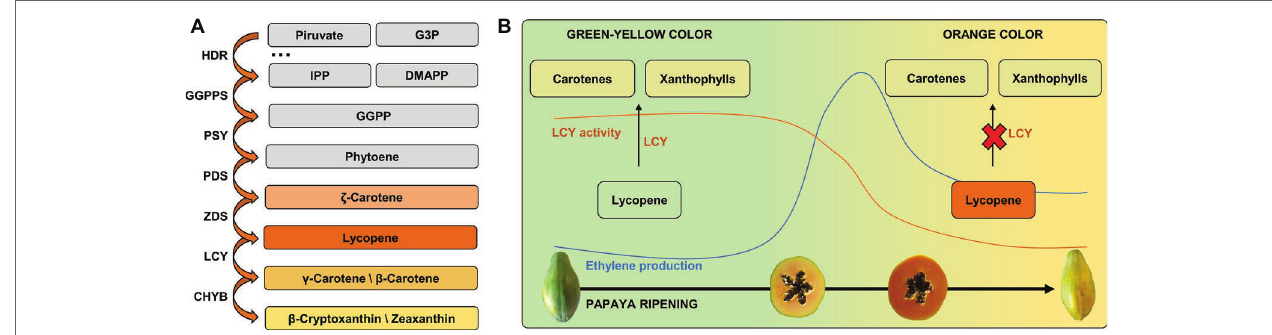
FIGURE 3 | Ethylene production and carotenoids accumulation (LCY activity) during papaya ripening: papaya’s green/yellow color changing to orange/red color. (A) Carotenoids derivated from MEP pathway. (B) Papaya LCY activity during ripening drives the lycopene accumulation and pulp color changes through the decreased conversion of lycopene in carotenes and xanthophylls. G3P, glyceraldehyde-3-phosphate; IPP, isopentenyl diphosphate; DMAPP, dimethyl allyl diphosphate; GGPP, geranyl-geranyl diphosphate; HDR, 4-hydroxy-3-methylbut-2-enyl diphosphate reductase; GGPPS, geranyl-geranyl diphosphate synthase; PSY, phytoene synthase; PDS, phytoene desaturase; ZDS, ζ -carotene desaturase; LCY, lycopene cyclase; CHYB, carotene